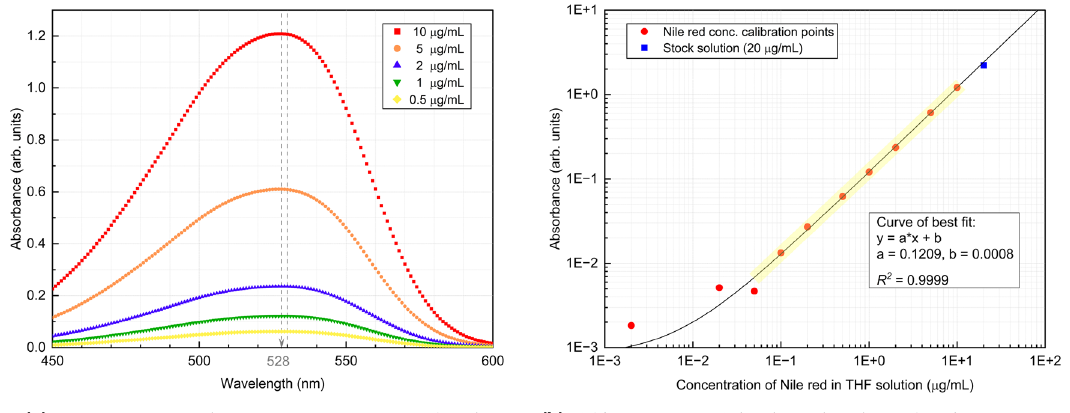
Figure 3. Absorbance spectrum ( a ), and final calibration curve ( b ) for Nile red solutions used to measure residual oil volume after displacement. The complete data set for UV–Vis spectra measurements ( a ), and the calibration curve ( b ) respectively can be found as Supplementary Tables S1 and S2 online.